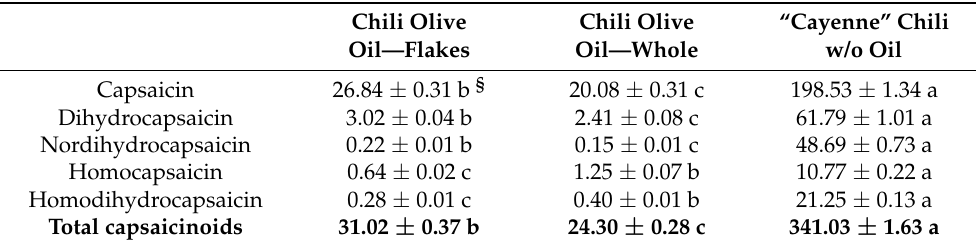
Table 4. Individual and total capsaicinoid content (mean ± SE) in chili olive oil and dry “Cayenne” chili before being added to the olive oil. Chili Olive Chili Olive “Cayenne” Chili Oil—Flakes Oil—Whole w/o Oil Capsaicin 26.84 ± 0.31 b